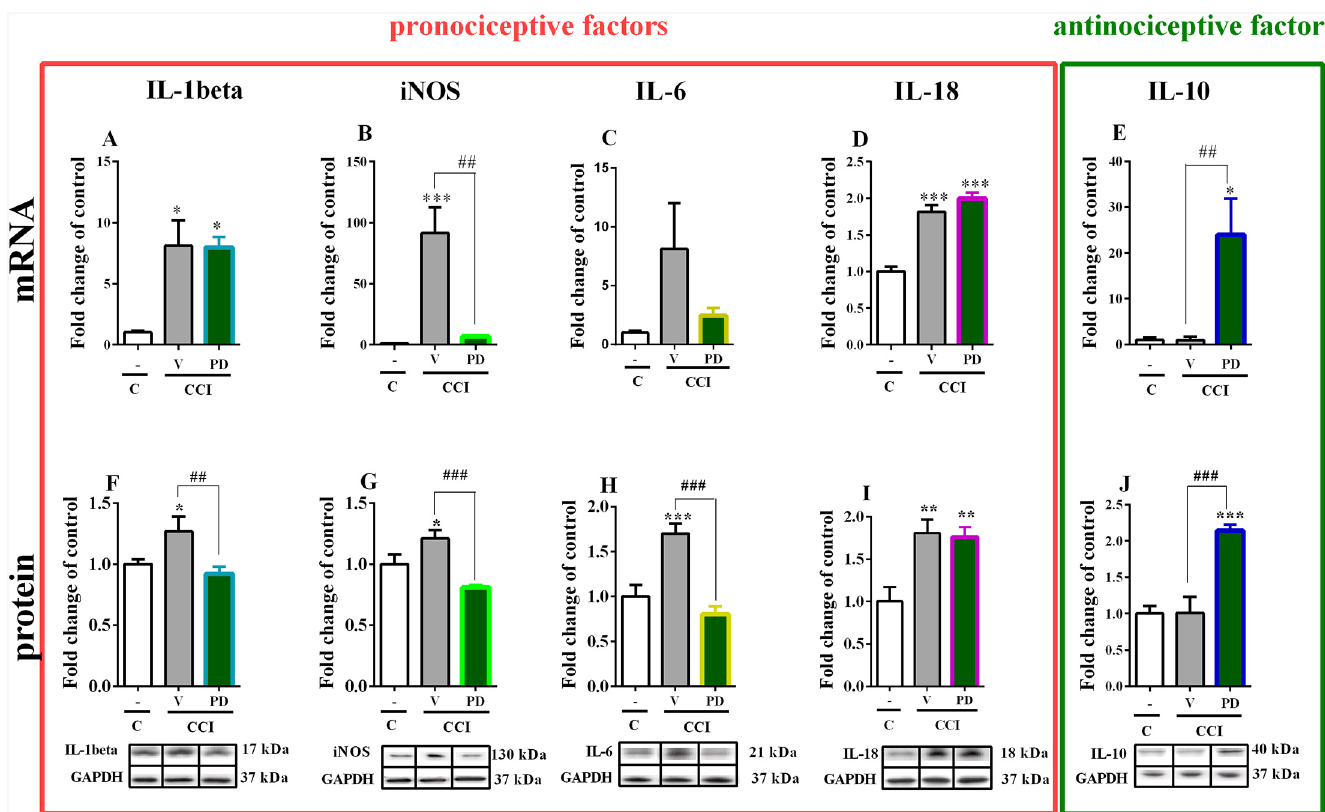
Fig 3. Effect of PD98059 on the mRNA and protein level of pro-inflammatory factors (IL-1beta, iNOS, IL-6 and IL-18) and anti-inflammatory factor (IL-10) in neuropathic pain. Effect of PD98059 (2.5 mcg/5 mcl; i . t .; 16 h and 1 h before CCI and then once daily for 7 days) on the mRNA and protein levels of IL-1beta (A, F), iNOS (B, G), IL-6 (C, H), IL-18 (D, I) and IL-10 (E, J) in the ipsilateral dorsal part of the lumbar spinal cord on day 7 after CCI. PD98059 prevent the upregulation of the mRNA levels of iNOS (B) and induced expression of mRNA for IL-10 (E), but did not influence the level of IL-1beta (A), IL-6 (C) and IL-18 (D) in the spinal cord during neuropathic pain. Repeated PD98059 treatment prevent the upregulation of the protein levels of IL-1beta (F), iNOS (G), IL-6 (H) and induced IL-10 (J), but did not influence the level of IL-18 (I) in the spinal cord during neuropathic pain. The data are presented as the fold change of control. The number of individual samples per group Figs A-E: C n = 4 – 5; V-CCI n = 6; PD-CCI n = 4 – 5; Figs F-J: C n = 4 – 6; V-CCI n = 5 – 8; PD-CCI n = 6 – 7. Inter-group differences were analyzed using Bonferroni's multiple comparison test. * p < 0.05, ** p < 0.01 and *** p < 0.001 indicate significant differences compared to the control group (C), and ## p < 0.01 and ### p < 0.001 indicate significant differences compared to the V-CCI rats (ANOVA, Bonferroni ’ s test). C, control; V, vehicle; PD,